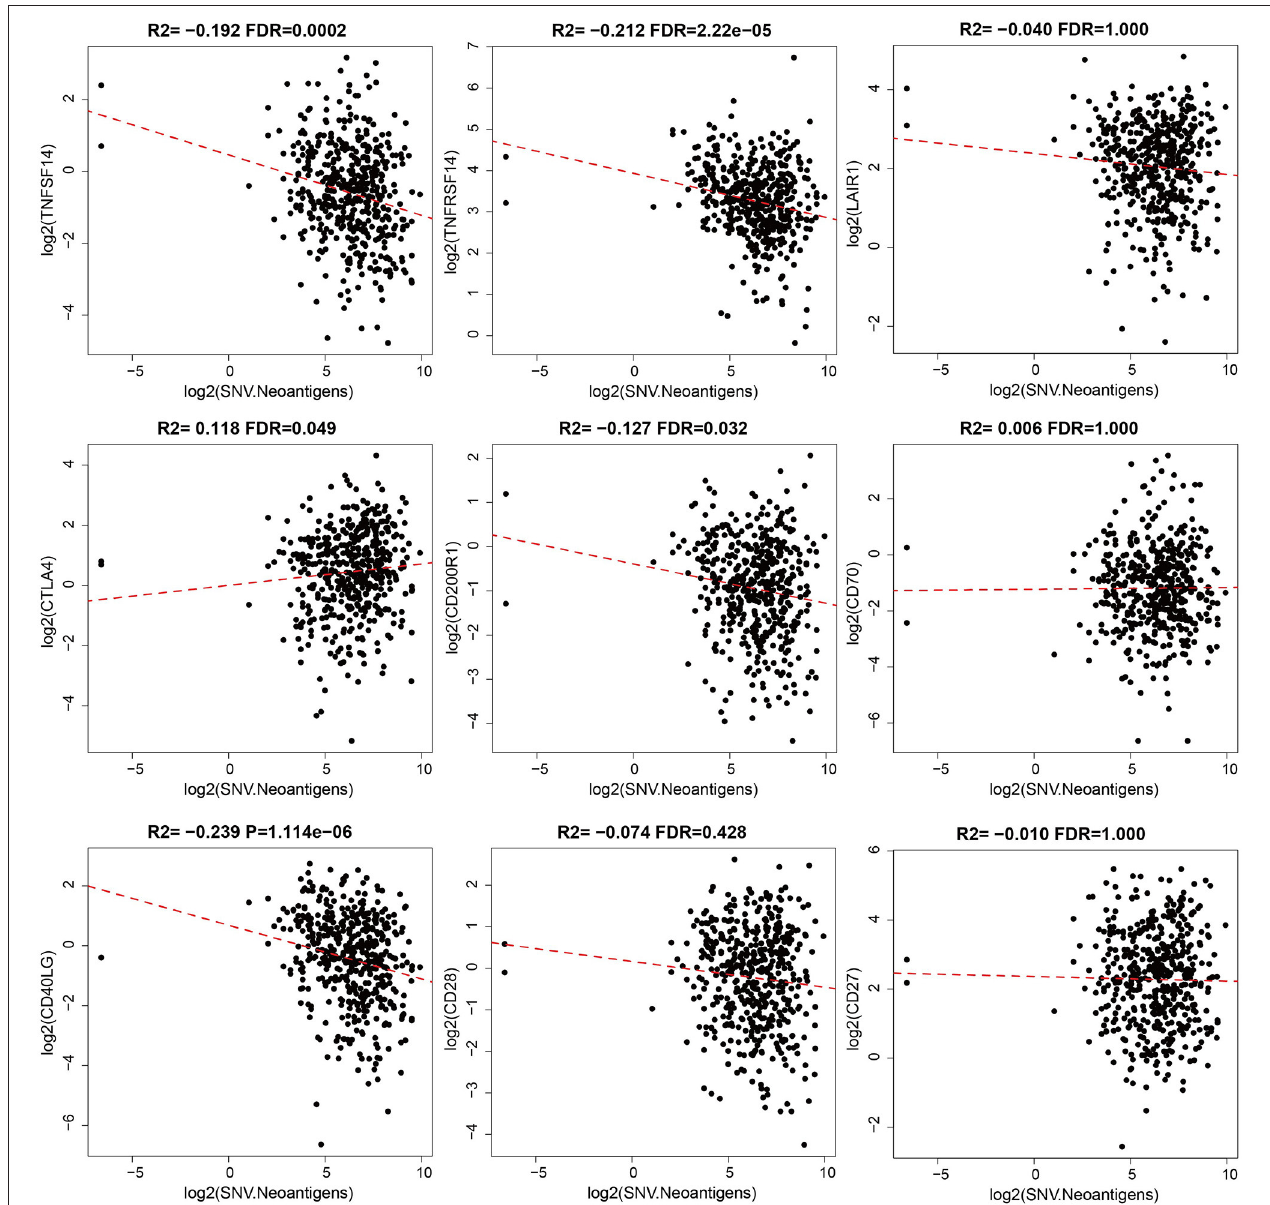
FIGURE 5 | Correlation scatter diagram of IGCs’ expression levels and neoantigens. R2 is the correlation coefficient, and FDR is false discovery rate. The abscissa represents log2 (neoantigens), and the ordinate represents